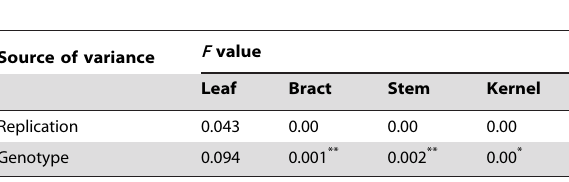
Table 2. Variance analysis of the four measured tissues for As concentration in the RIL. population.